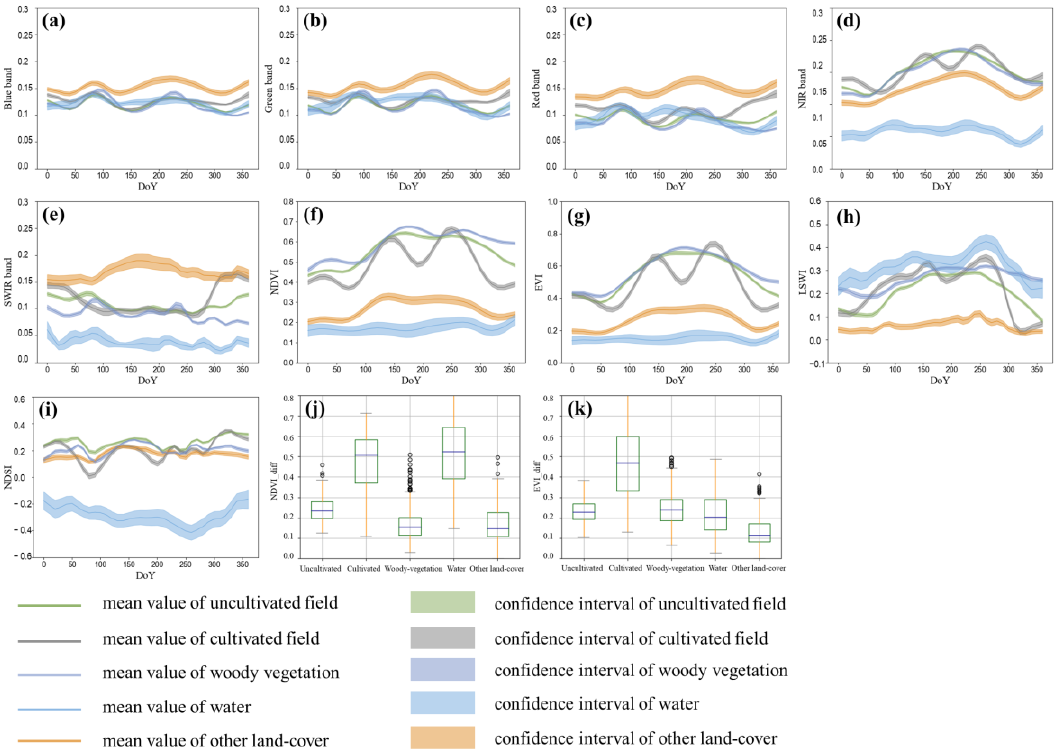
Figure 7. Selected sensor bands temporal profiles of different land covers (uncultivated filed, culti- vated filed, woody vegetation, water, and other land-cover), including blue band ( a ), green band ( b ), red band ( c ), NIR band ( d ) and SWIR band ( e ); and selected spectral indices temporal profiles of different land covers, including NDVI ( f ), EVI ( g ), LSWI ( h ), and NDSI ( i ); selected features of NDVI_diff(j) and EVI_diff (k) were the annual difference in NDVI and EVI, respectively.